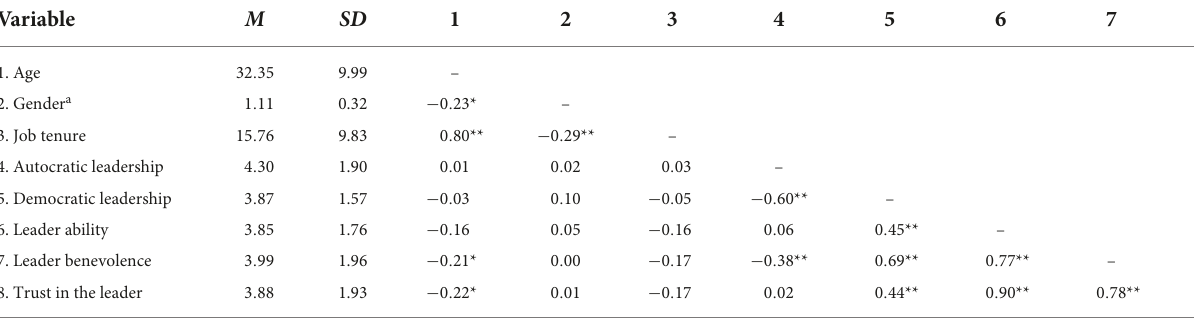
TABLE 2 Descriptive statistics and intercorrelations among Study 1 variables. Variable